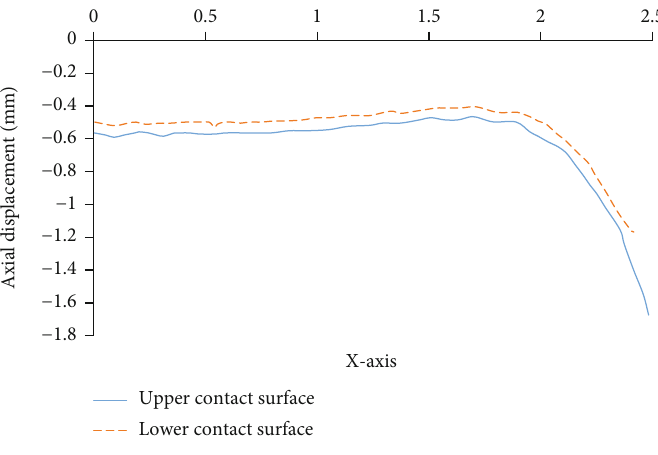
Figure 22: Axial displacement of proppant contact